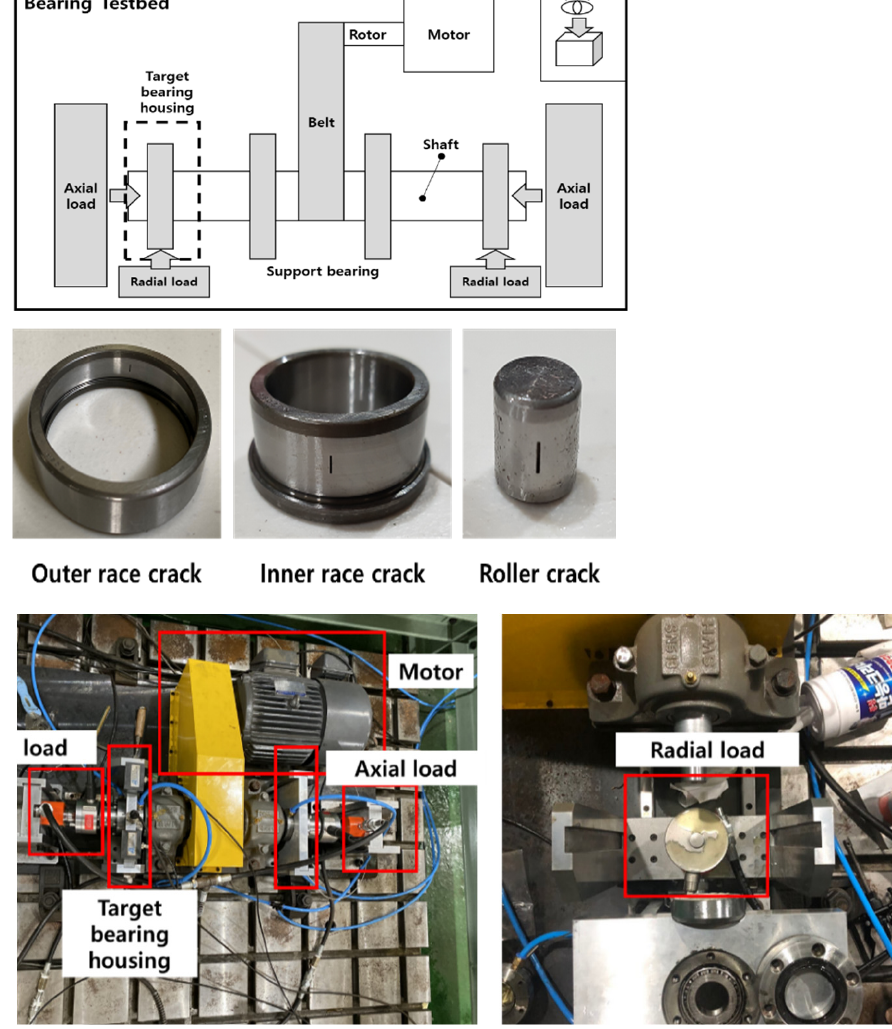
Figure 5. Images of the bearing test platform.